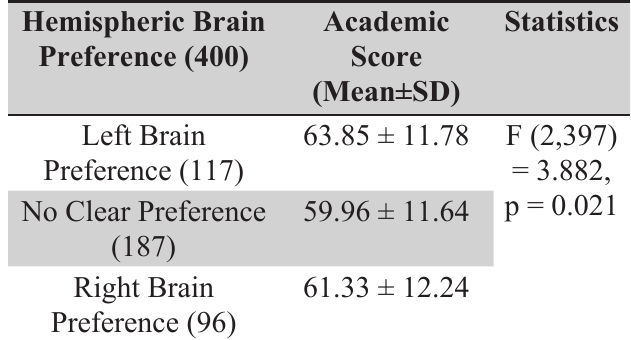
Table 1: Academic score in percentage of